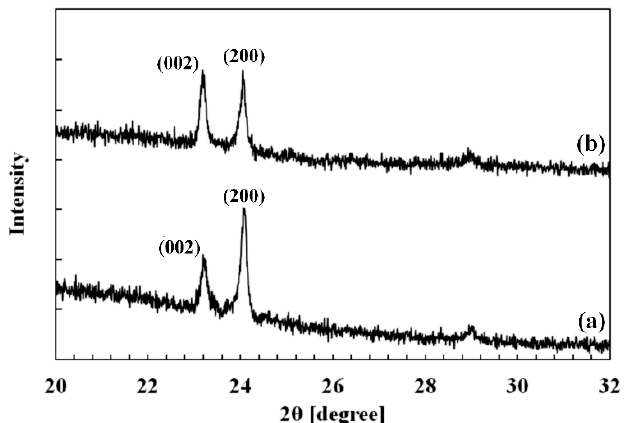
Figure 3. XRD spectra of WO 3 films annealed at 400 ◦ C (a) and 500 ◦ C (b) for 6 h in air. Peak indexa- tions are related to either triclinic ( δ -WO 3 ), monoclinic ( γ -WO 3 ), or orthorhombic ( β -WO 3 ) struc- tures.